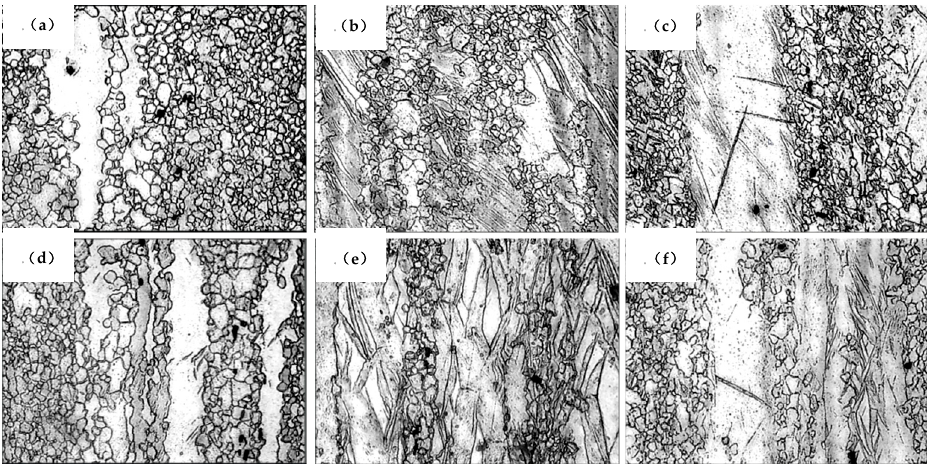
Figure 8. Optical microscope images of compression along the 45ED: ( a ) 0.01, ( b ) 0.05, and ( c ) 0.15; and the PED: ( d ) 0.01, ( e ) 0.05, and ( f )